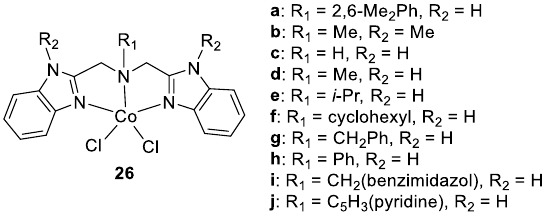
Figure 15. Bis(benzimidazole)-amine cobalt dichloride complexes. The flexible aryl-substituted N -picolylethylenediamine and diethylenetriamine ligands were synthesized to ligate iron and cobalt chloride by Solan [120]. These iron and cobalt complexes 27 (Figure 16) activated by excess MAO showed moderate activities for ethylene oligomerization. Notably, the iron-based catalysts afforded linear α -olefins, while the cobalt-based catalysts produced mixtures of linear and branched products.